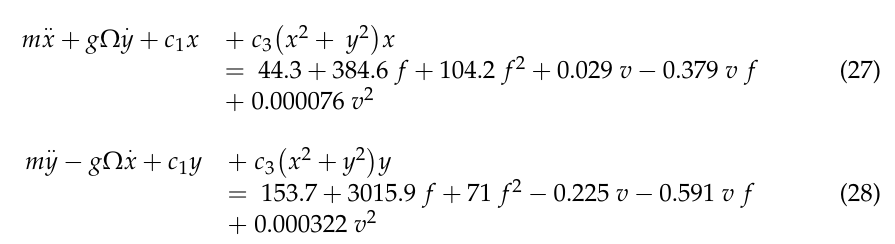
Table 2. Amplitude R and frequency 𝜔 of vibration for various values of feed rate f and velocity v .